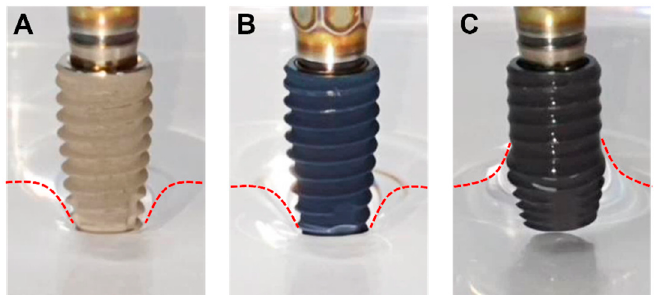
Figure 2. ( A ). SLA, ( B ). CaSLA, and ( C ). PCaSLA images after dipping the implants into a DW reservoir. Red dotted lines were drawn along the DW surfaces.